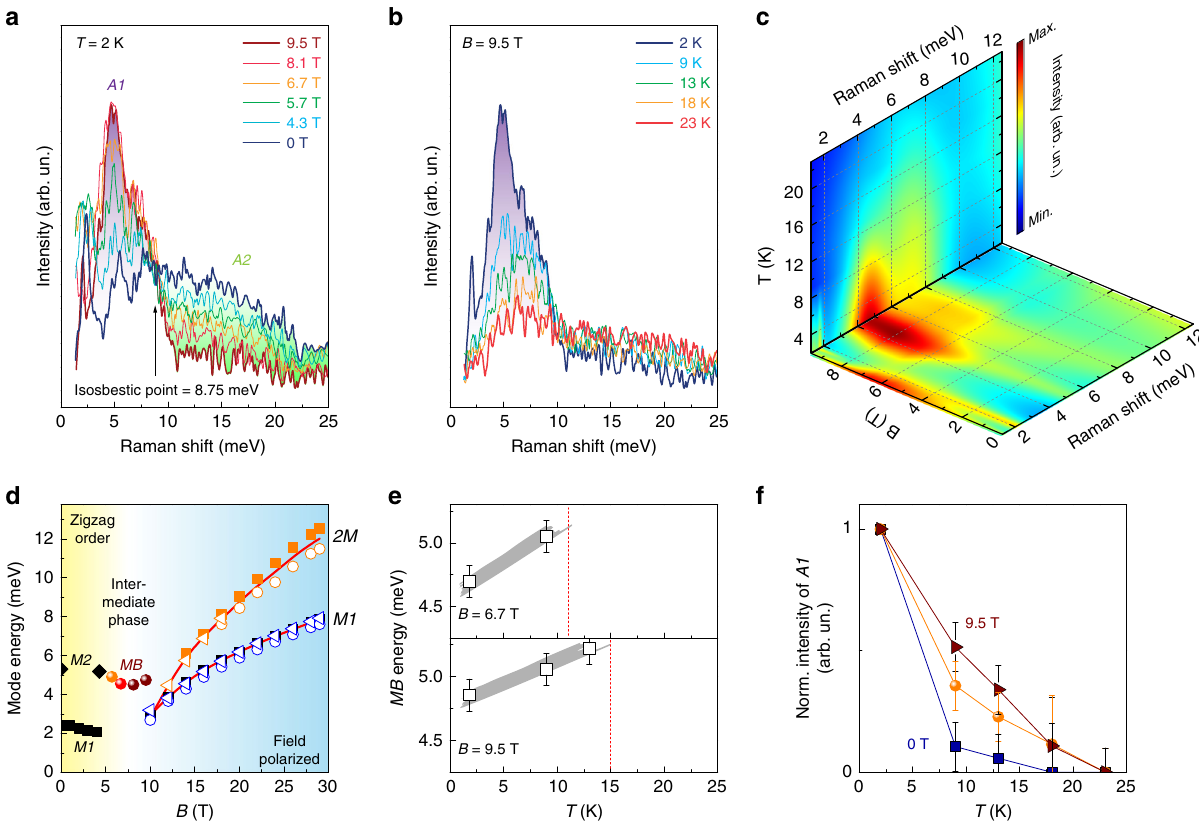
Fig. 3 Spectral weight redistribution and formation of a bound state through B c . a Raman spectra obtained at T = 2 K with increasing magnetic fi elds. b Raman spectra at B = 9.5 T recorded with increasing temperatures. Phonon modes are subtracted in ( a ) and ( b ) for better visualization of the magnetic excitations. c Contour plot of the magnetic Raman scattering intensity as a function of temperature and fi eld. d Field-dependence of excitations around the intermediate phase (spheres) together with spin-wave excitations at low and high magnetic fi elds. e Thermal evolution of the MB mode energy at B = 6.7 and 9.5 T. Gray lines are guides to the eyes. f Thermal melting of the low-temperature magnetic modes at 0, 6.7, and 9.5 T. Standard deviations in ( e , f ) are indicated by error